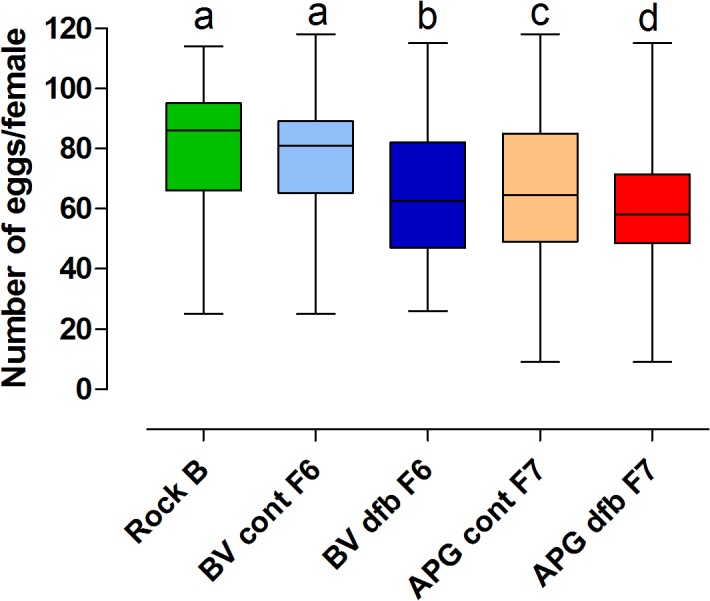
Number of eggs laid by Rockefeller (Rock) females, and selected (dfb) or control (cont) groups of Boa Vista (BVT) and Aparecida de Goiânia (APG) mosquitoes.
Box-plots and letters above them are as for Fig 7. All groups were compared pairwise except for control and selected groups from each tested population.